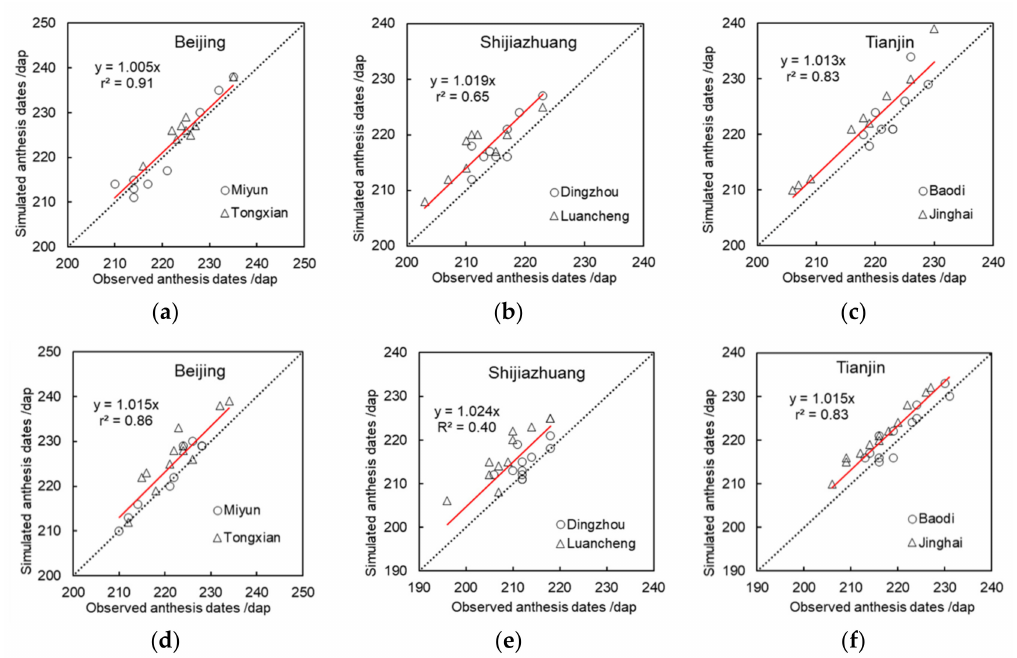
Figure 2. Calibration and validation results of anthesis dates. ( a – c ) are calibration results for Beijing, Shijiazhuang, and Tianjin, respectively; ( d – f ) are validation results for Beijing, Shijiazhuang, and Tianjin,